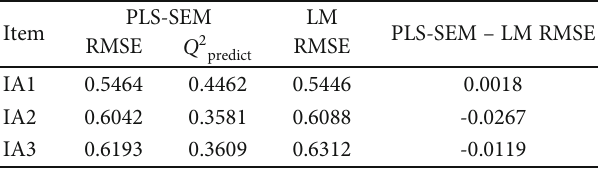
Table 8: PLSpredict assessment of manifest